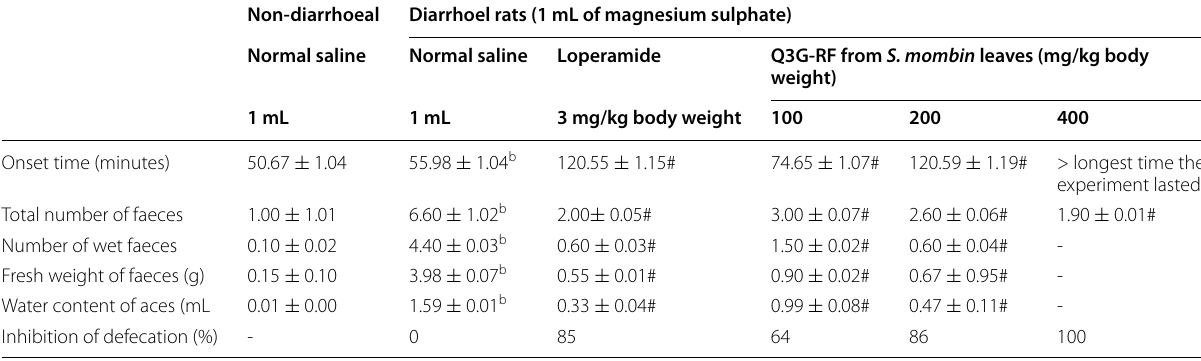
Values are mean of 6 replicates SEM, significant differences from the sham control group are indicated by b and from negative control by #, p < 0.05 ±